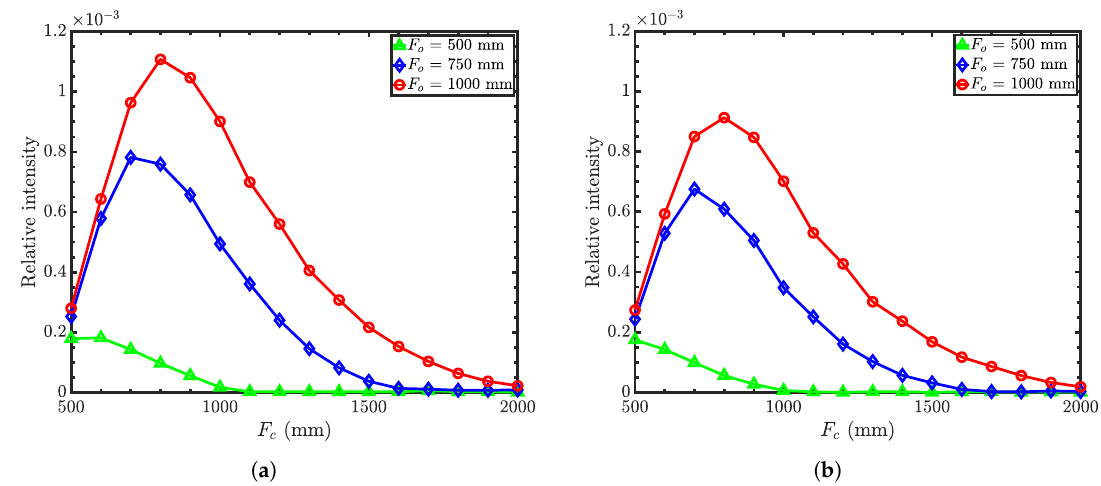
Figure 4. Intensity at the detector (relative to the source) for different objective focal lengths of Wolter I microscopes. Objective focal lengths F 0 = 500 mm (triangles), 750 mm (diamonds), and 1000 mm (circles). ( a ) Guide-to-condenser distance = 500 mm. ( b ) Guide-to-condenser distance = 1000 mm. The simulations were conducted with 10 6 rays.